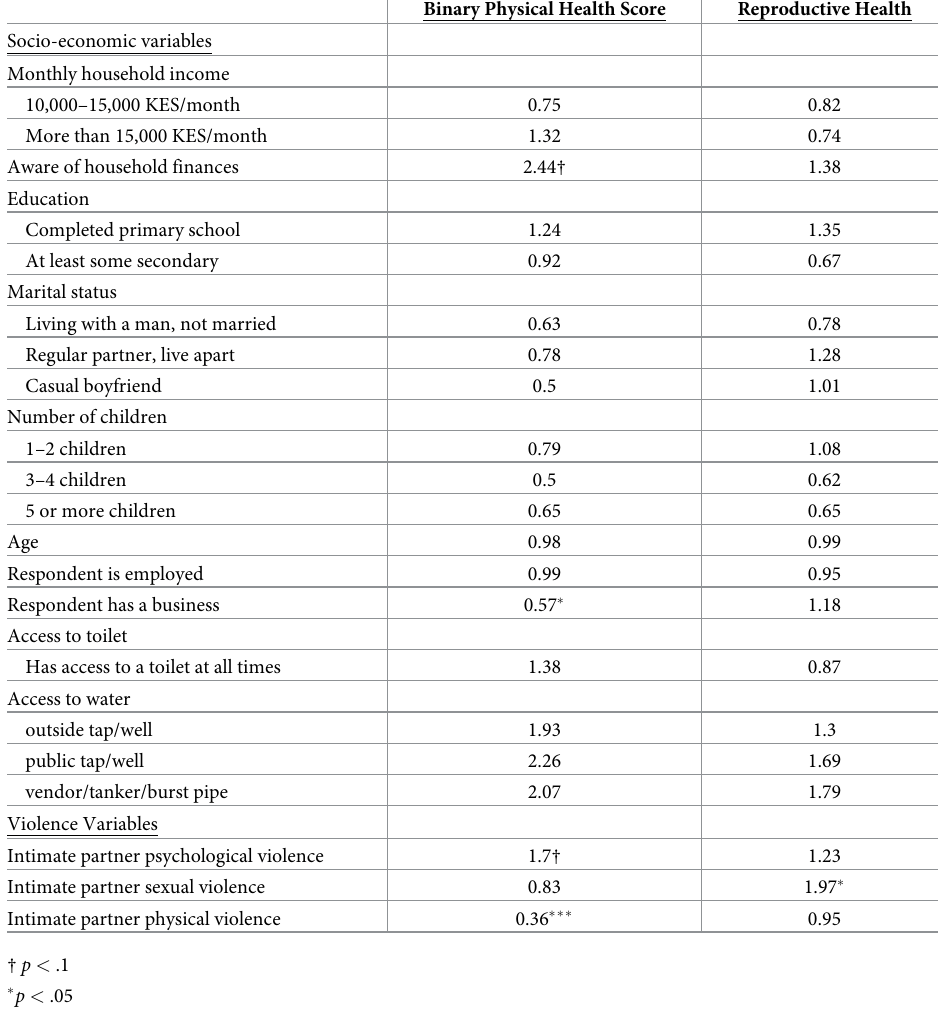
Table 3. Summary of adjusted odds ratios from logistic regression of women’s physical health on their experi- ences of IPV and other potential correlates and